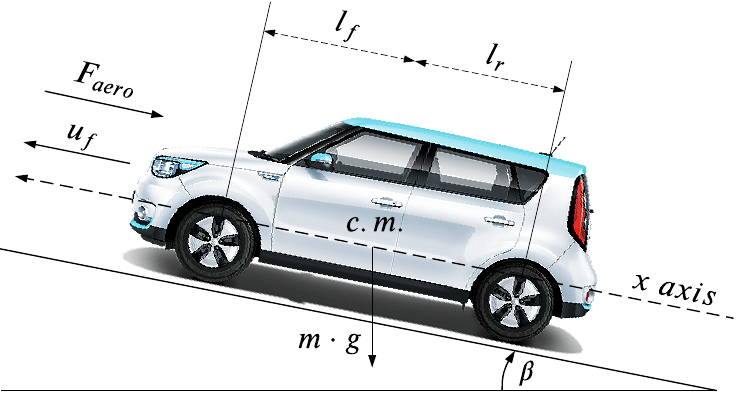
Figure 2. Diagram of longitudinal forces acting on a vehicle.